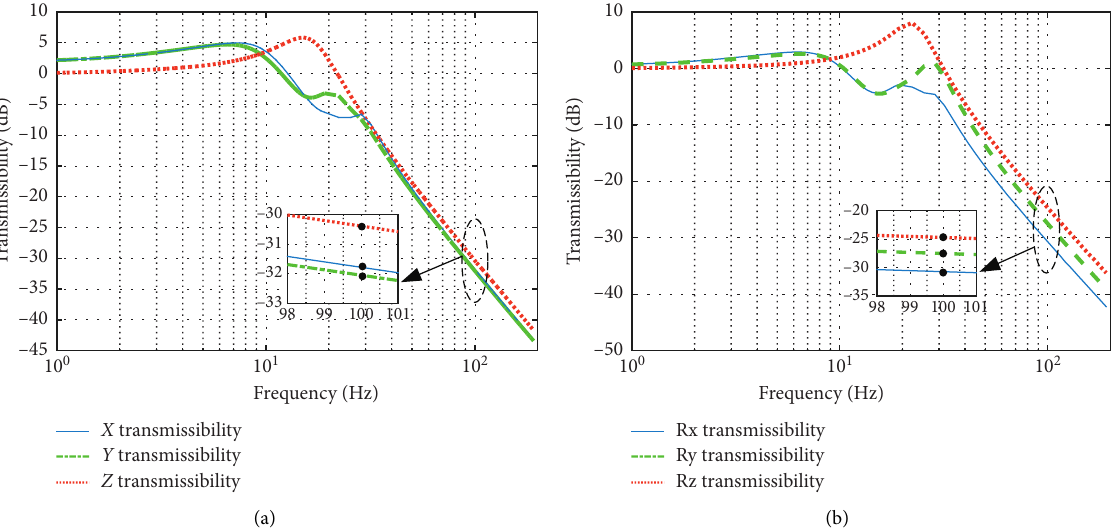
Figure 10: Transmittance curve of Stewart vibration isolation system in six directions. (a) Transmissibility in the translational direction. (b) Transmissibility in the rotational direction.